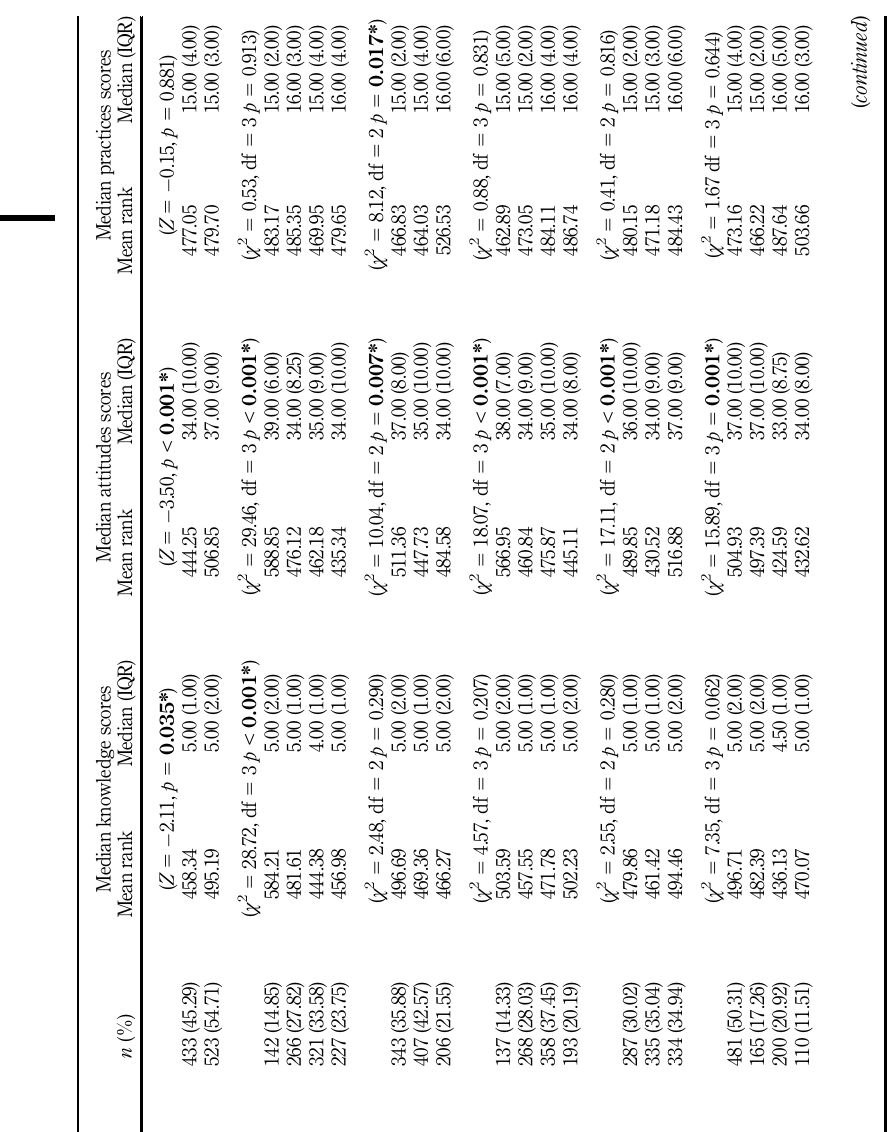
Table I. Differences in patients ’ median KAP scores across independent variables ( N 5